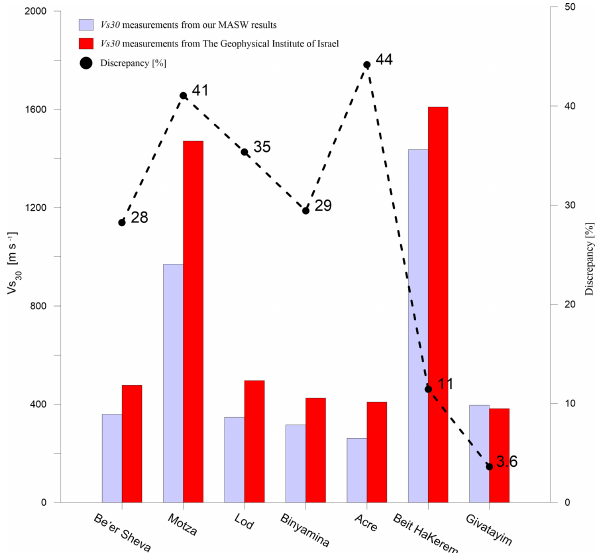
Figure 9. Comparison between our V s those calculated from GII’s report (red) (Aksinenko and Hofstetter, 2012).